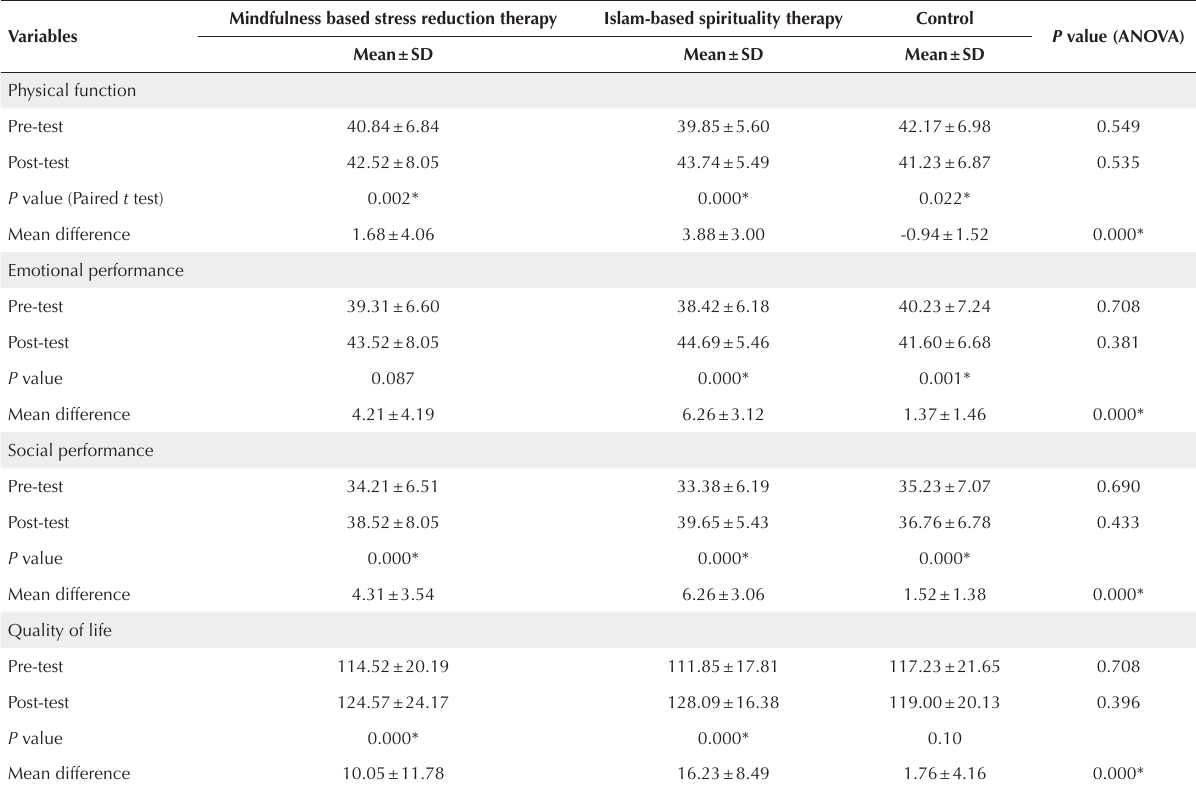
Table 4. Mean and standard deviation of the dependent variable in the experimental and control groups at pretest and posttest